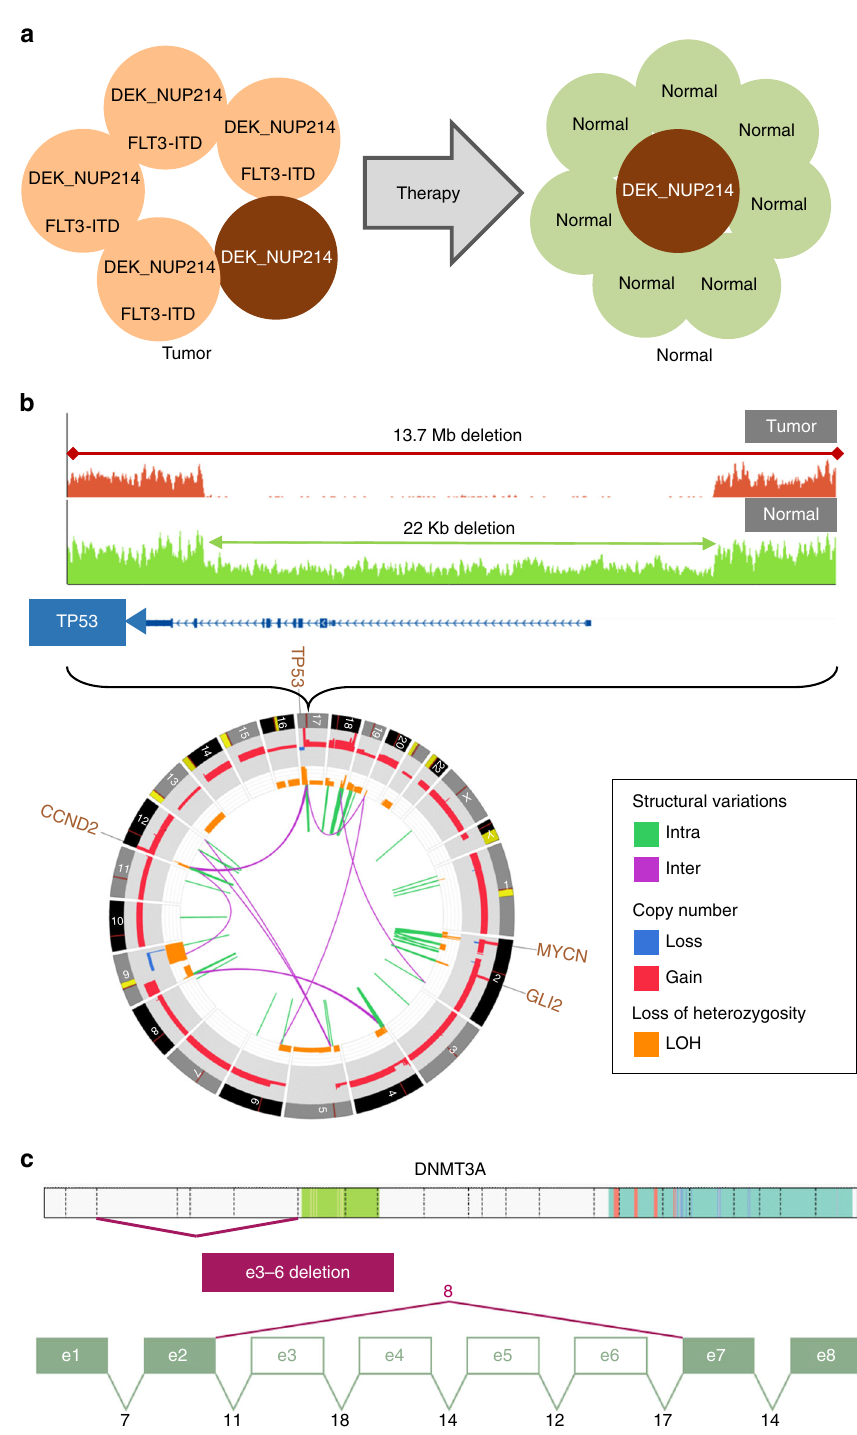
Fig. 6 Examples of novel fi ndings due to inclusion of WGS. a Illustration of residual tumor detected in the normal sample of an AML. Associated read counts can be found in Table 1. b Germline TP53 deletion detected in a medulloblastoma. The tumor genome has a second somatic hit (i.e. a 13.7 Mb deletion) resulting in homozygous deletion of TP53 . The tumor genome, shown in CIRCOS, underwent complex re-arrangement resulting in high ampli fi cation in GLI2 , MYCN , and CCND2 . c A variant of uncertain signi fi cance (VUS) in DNMT3A in a neuroblastoma. This variant deletes exons 3 – 6 of DNMT3A with aberrant transcription predicted to result in an in-frame deletion of the protein. The purple line linking exons 2 – 7 is annotated with the RNA- Seq read count of the aberrant splice junction caused by the deletion. The read count supporting each canonical splice junction is displayed